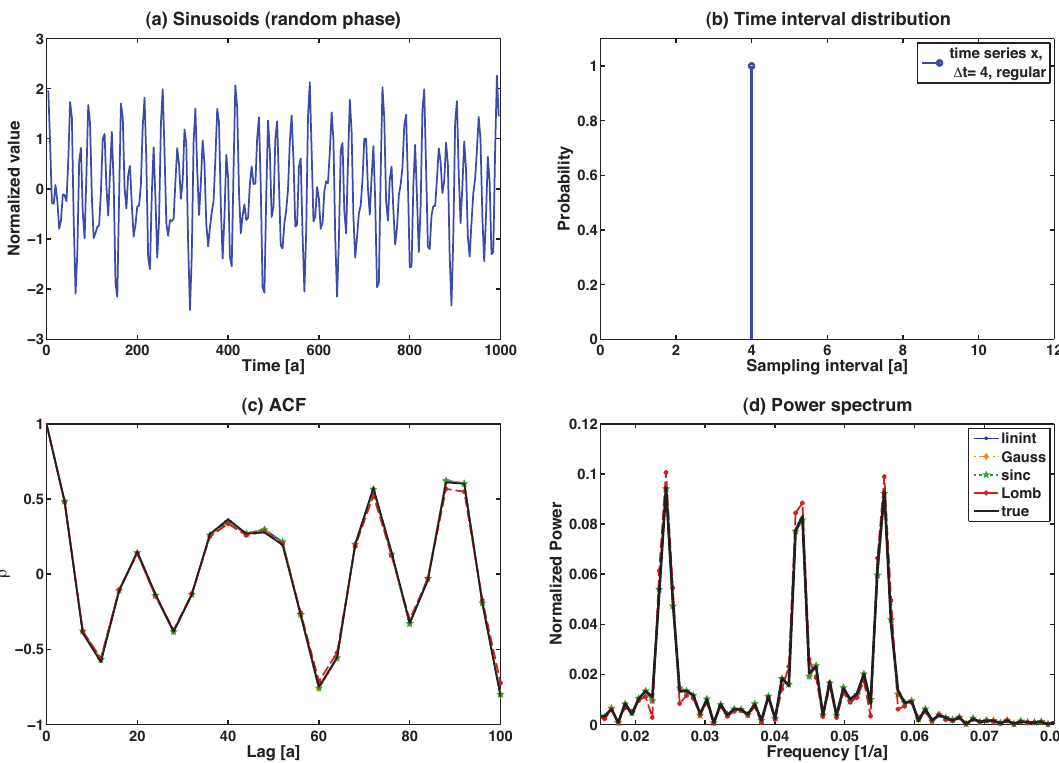
Fig. 4. Autocorrelation analysis of synthetic signals: for a regularly sampled combination of sinusoids (cf. Eq. 14) we give a sample time series (a) , the sampling interval probability density (b) , the expected correlation function (c) and the corresponding power spectrum (d) determined from 100 realizations of sinusoid time series with random phase arguments. Legends for each row are given in the right panels. All estimators perform equally well.